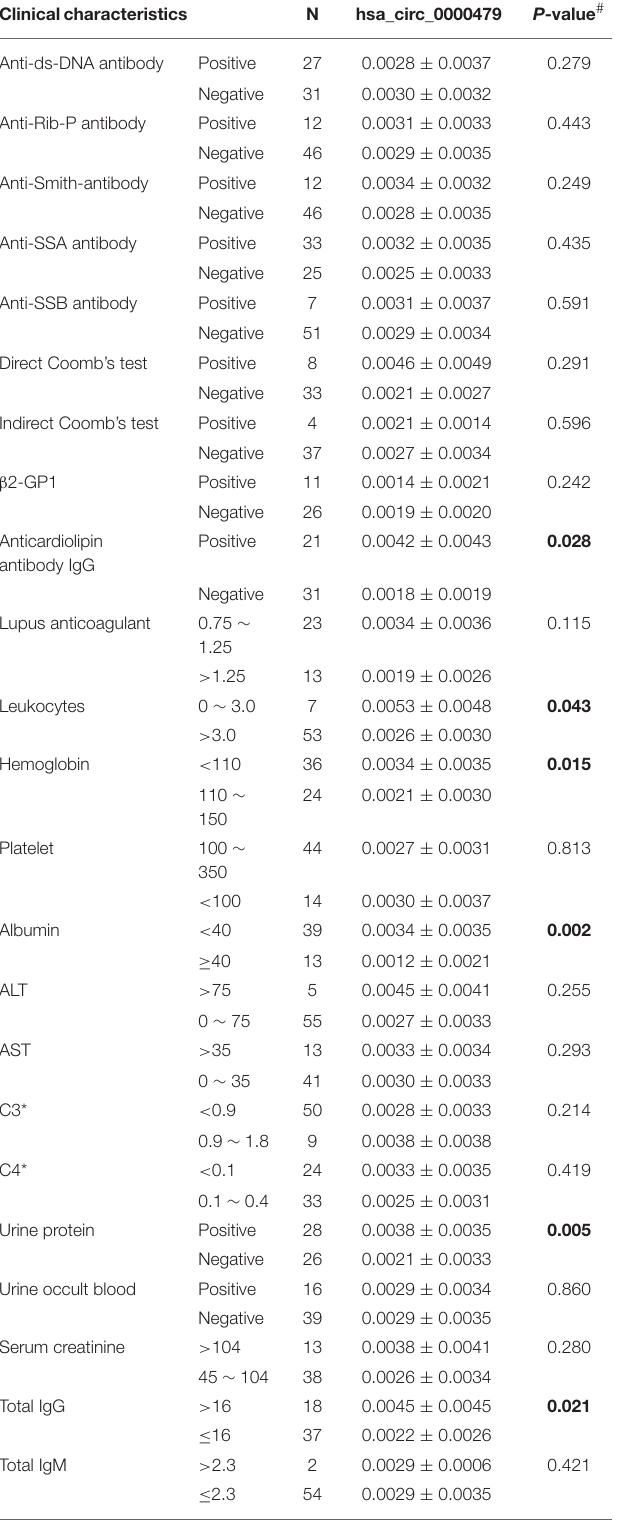
TABLE 1 | Correlation of the expression of the hsa_circ_0000479 and clinical features of SLE.